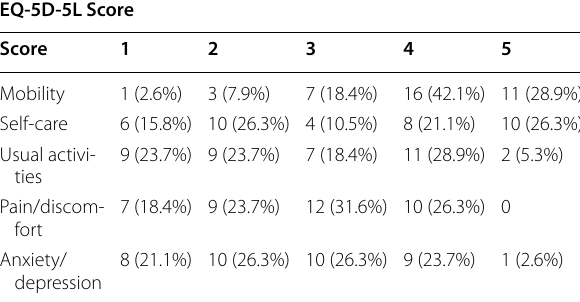
Table 4 General health status